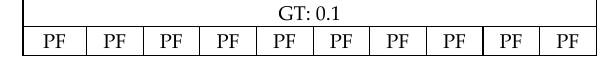
Figure 6. The PFs once again expanded N times ( PacketSize × N × N ).